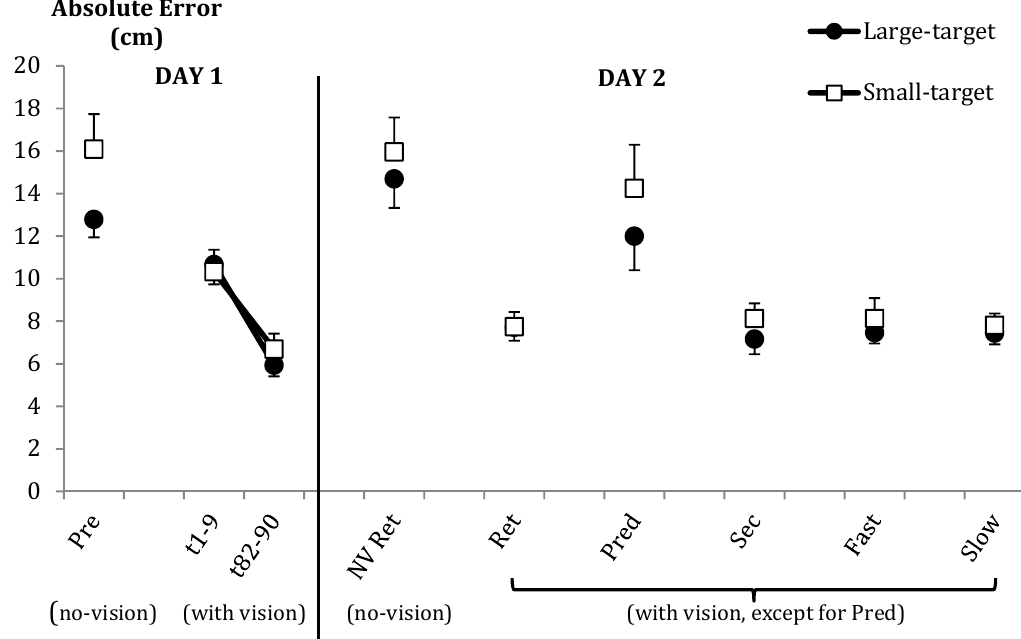
Figure 4. Mean absolute error (and SE bars) as a function of testing phase and condition. Pre = No-vision pretest; t1–9 = First nine acquisition trials; t82–90 = Final nine acquisition trials; NV Ret = No-vision retention; Ret = Retention; Pred = Outcome prediction test (no vision), Sec = Secondary task test; Fast = Fast-paced test, and Slow = Slow-paced test.